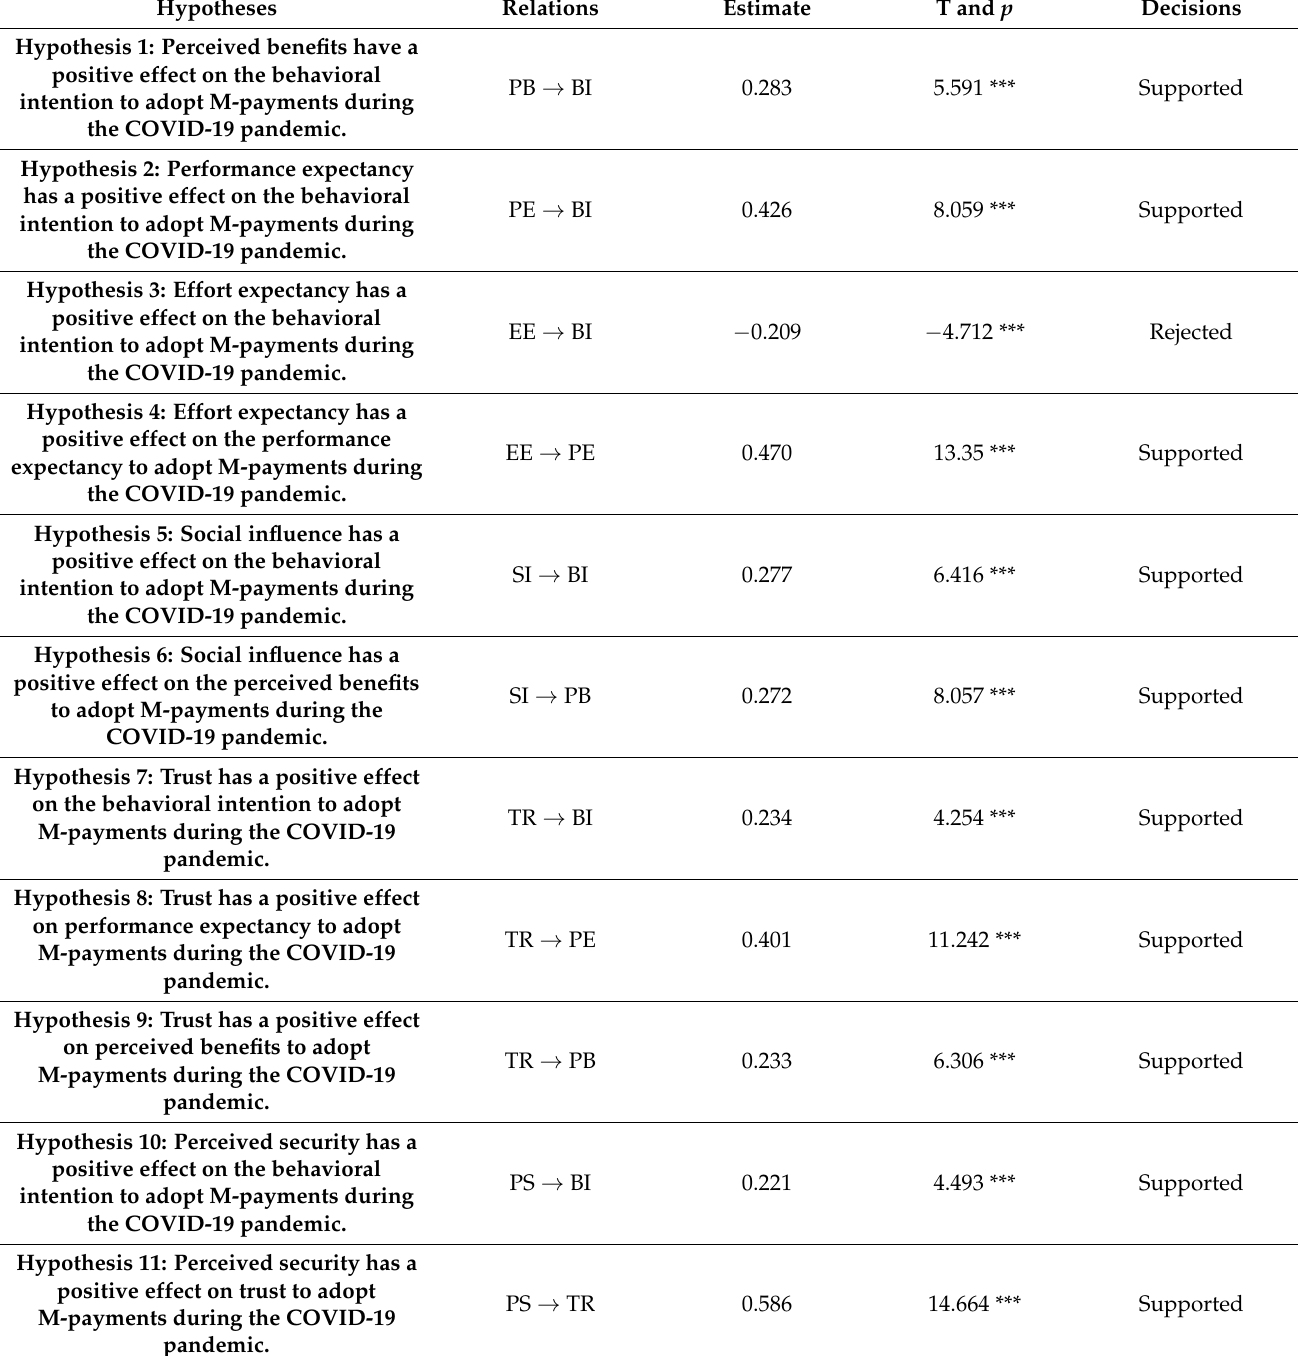
Table 6. Hypotheses testing